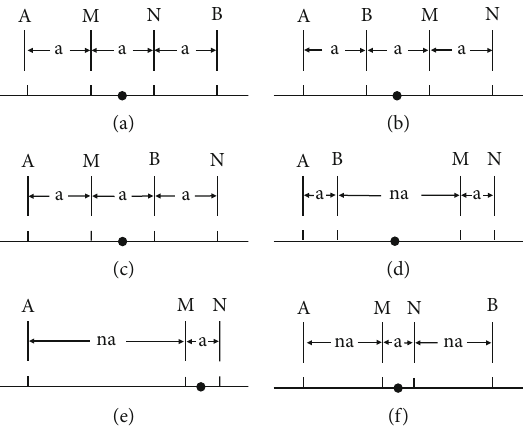
Figure 8: Some commonly used electrode arrays. (a) Wenner α , (b) Wenner β , (c) Wenner γ , (d) dipole-dipole, (e) pole-dipole, and (f)